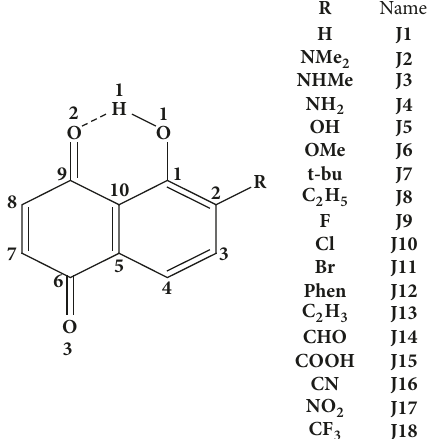
Figure 1: Numbering system used to designate specific atom of juglone and its derivatives followed by specification of electron donating or withdrawing substituent